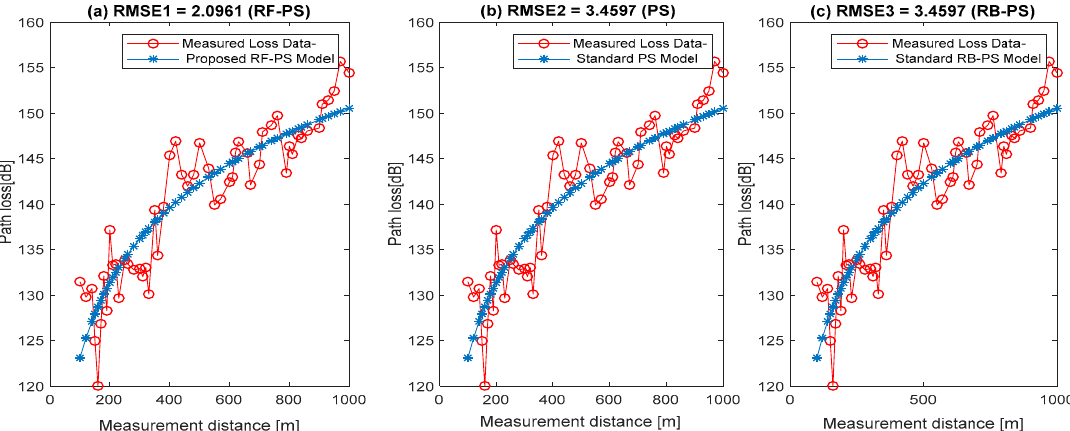
Figure 14. Results showing the measured path loss versus distance using the hybrid RF-PS method and two existing standard path loss prediction methods in site 1 of location 3.